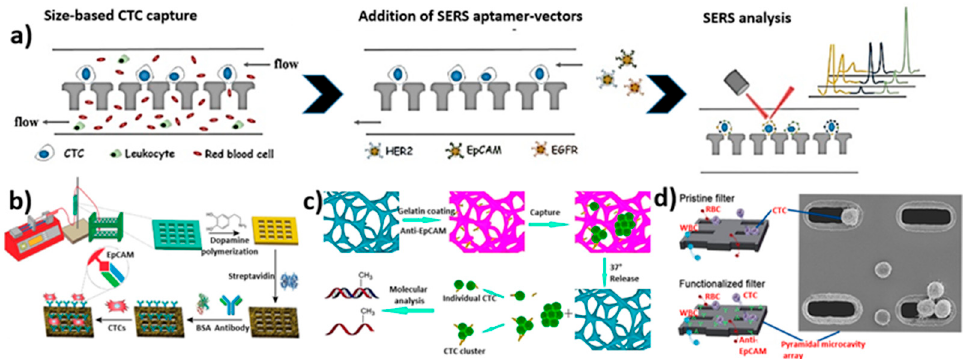
Figure 8. Schematic illustration of microfluidic devices for the isolation of CTCs using various techniques. ( a ) Working strategy of SERS nano vectors for CTC capture, cell phe-notype profiling and multivariate analysis for in situ profiling of CTCs; reprinted with permission from ref. [166], 2018, John Wiley and Sons. ( b ) Schematic of the working setup of the microfluidic platform and surface modification of 3D-printed microfluidic device with an-ti-EpCAM antibody for the isolation of CTCs; reprinted with permission from ref. [81], 2020, Elsevier. ( c ) Schematic surface modification of 3D Ni foam scaffold with gelatin and anti-EpCAM to capture CTCs; these were released at 37 °C for molecular analysis; reprinted with permission from ref. [167], 2017, American Chemical Society. ( d ) Schematic of CTC isolation by a filtration chip functionalised with anti-EpCAM antibody and SEM image of captured cells on pyramidal MCA; reprinted with permission from ref. [170], 2019, Elsevier.